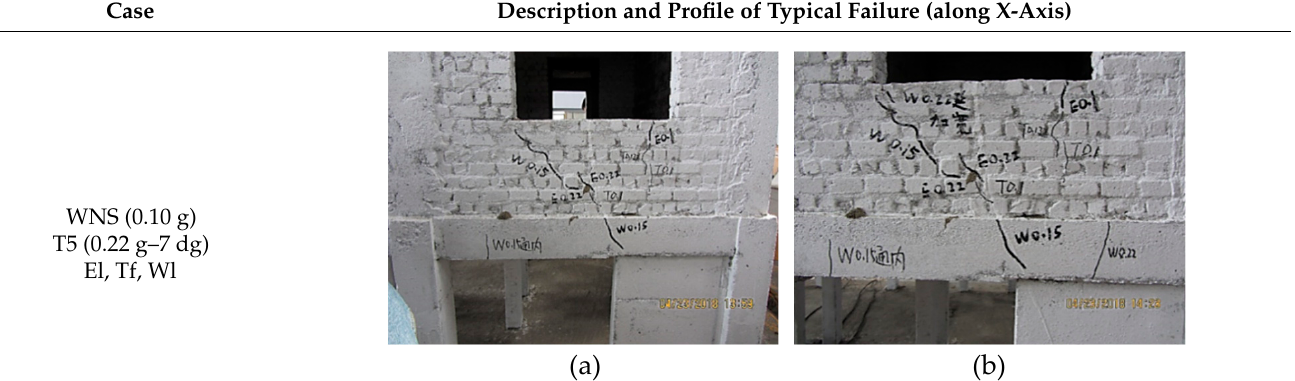
Table 5. Cont. Slight cracks appeared at the location of the window contact with the lintel (a). The oblique crack appeared from the window corner to the side beam. Case Description and Profile of Typical Failure (along X-Axis)